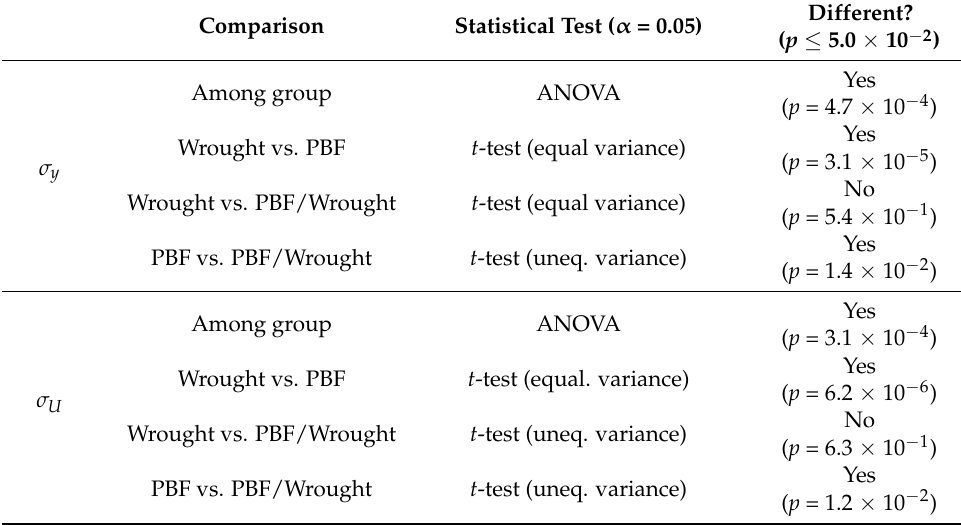
Table 3. Statistical analysis of tensile